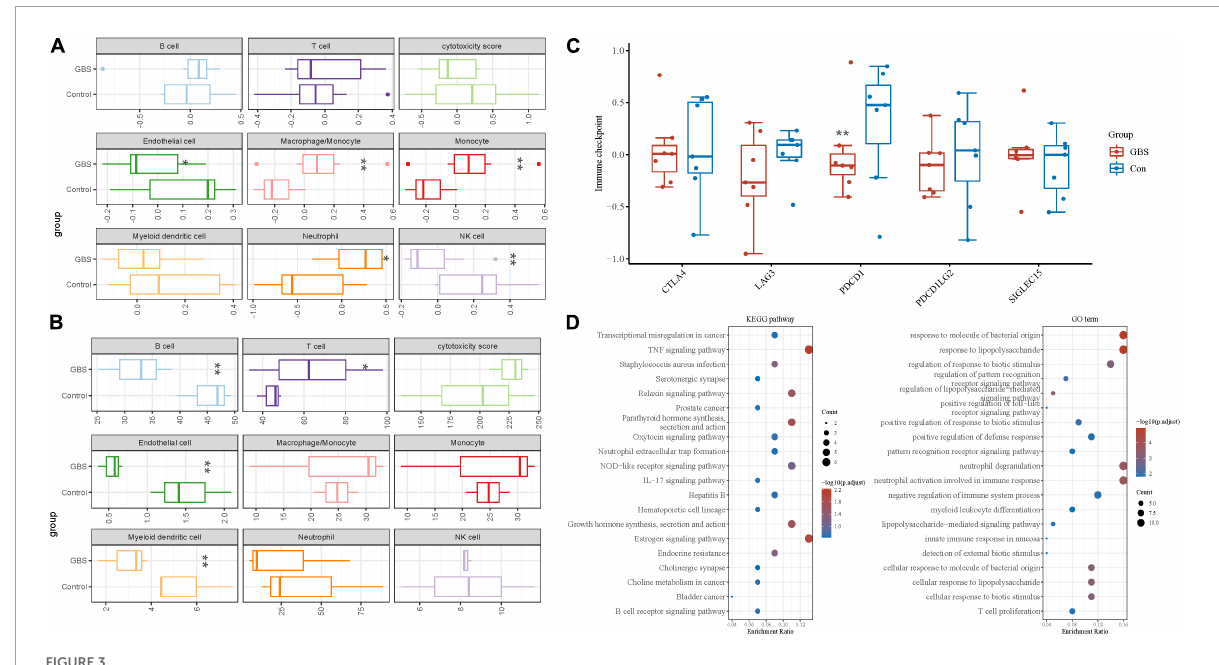
FIGURE3 Immune cell fractions and immune checkpoint analysis. (A,B) Immune cell fractions in GSE31014 and GSE72748. (C) Immune-checkpoint-related genes in the discovery dataset. (D) The KEGG pathway and GO term analysis in the discovery dataset. * p < 0.05; ** p <